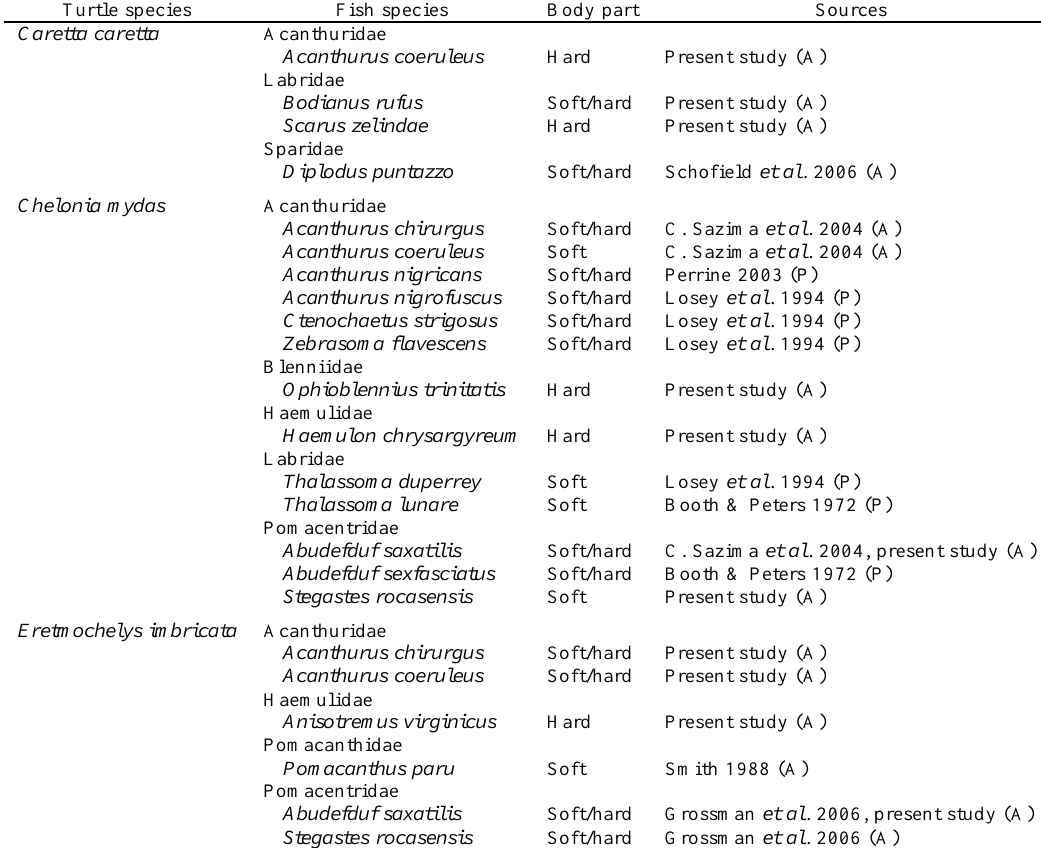
Table 1. Reef fishes recorded cleaning sea turtles in the Atlantic (A) or the Pacific (P) oceans. “Soft” refers to fishes foraging on the surface of soft body parts (head, neck, flippers), whereas “hard” refers to foraging on the surface of hard body parts (carapace, plastron). Turtle species in alphabetical order, and fish families and species arranged similarly for each turtle species. Turtle